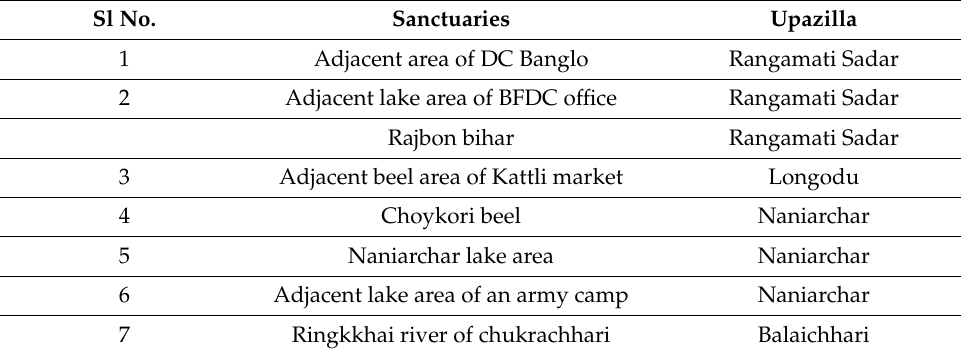
Table 8. Sanctuaries for fisheries protection in KL under the Fish Act 1950 [9]. Sl